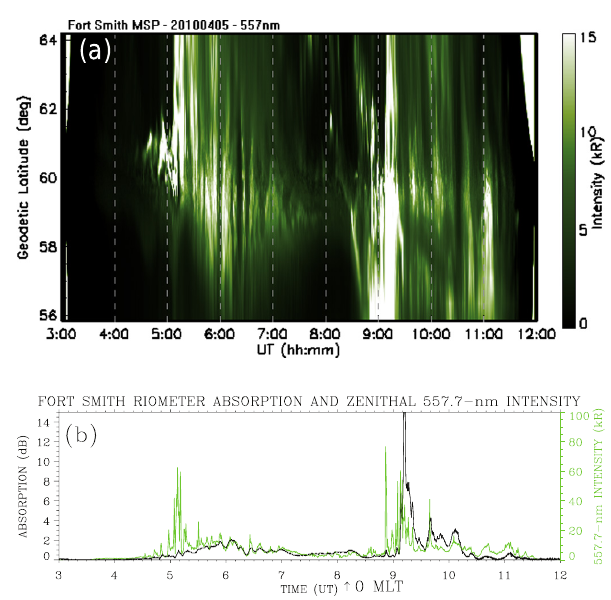
Fig. 3. (a) The 557.7-nm auroral emission as a function of geodetic latitude and UT extracted from all-sky images and (b) cosmic noise absorption observed in Fort Smith (60.0 ◦ N, 248.1 ◦ E). The zenithal 557.7-nm intensity (green line) is superposed. The arrow indicates magnetic local